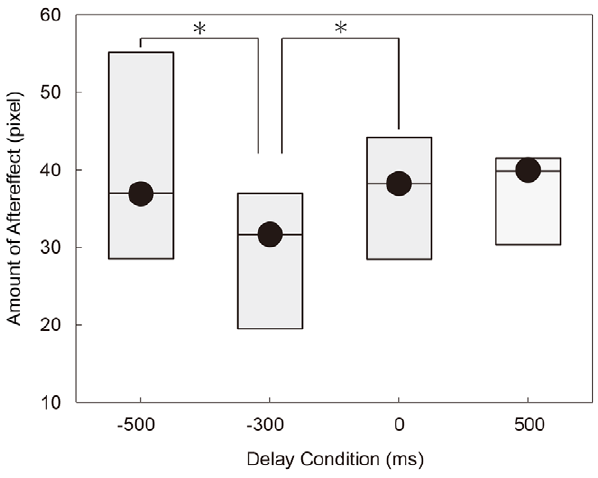
Figure 4. Results of Supplementary Experiment. The estimated aftereffect ( A d : see Materials and Methods) is plotted for four delay conditions. The box plot shows the quartiles: thick segments indicate the medians, and the top and bottom of the boxes show the 25th and 75th percentiles. Asterisks indicate significant difference ( p , 0.05) detected by a post-hoc multiple comparison test (Scheffe’s method). The amount of after effect was significantly larger when the feedback was given 100 ms after the movement offset and at the task end, compared to the case that it was given 300 ms before the task end.